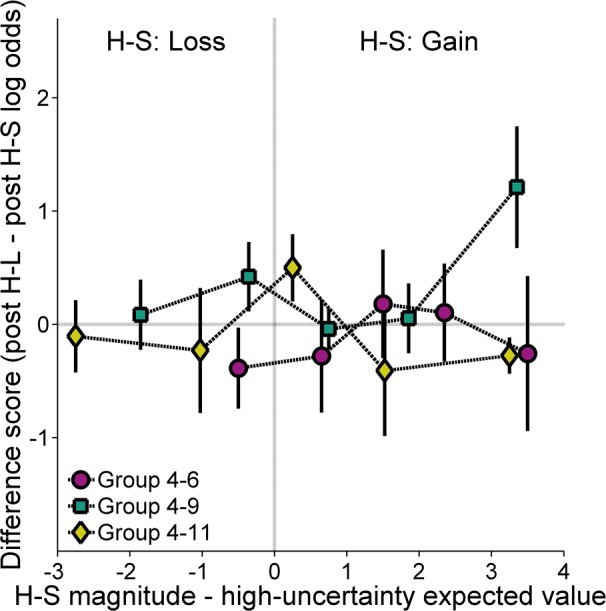
Mean (±SEM) difference score between the log odds of high-uncertainty choices following high-uncertainty-large (H-L) outcomes and the log odds of high-uncertainty choices following high-uncertainty-small (H-S) outcomes for each group in Experiment 2 as a function of the difference between the magnitude of the H-S outcome and the expected value of the high-uncertainty choice.A negative/positive difference on the abscissa indicates that the H-S outcome magnitude was greater than/less than the expected value of the high-uncertainty choice (gain/loss, respectively). A negative or positive difference on the ordinate reflects a greater likelihood to make high-uncertainty choices following H-S or H-L outcomes, respectively.